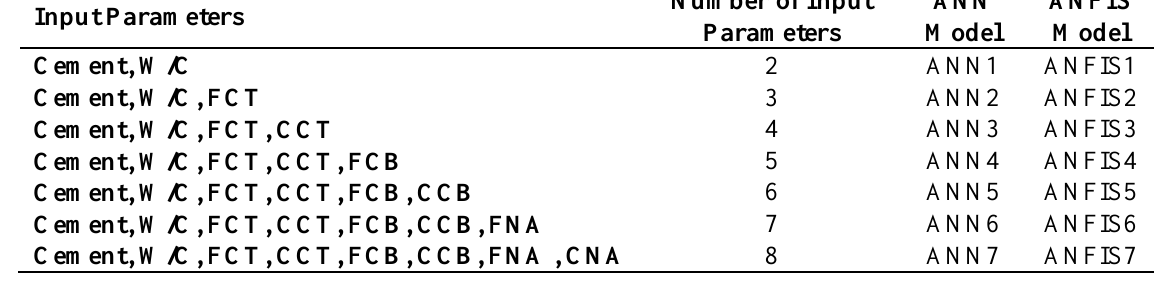
Characteristics and number of input parameters for each modeled ANN and ANFIS models. Input Parameters